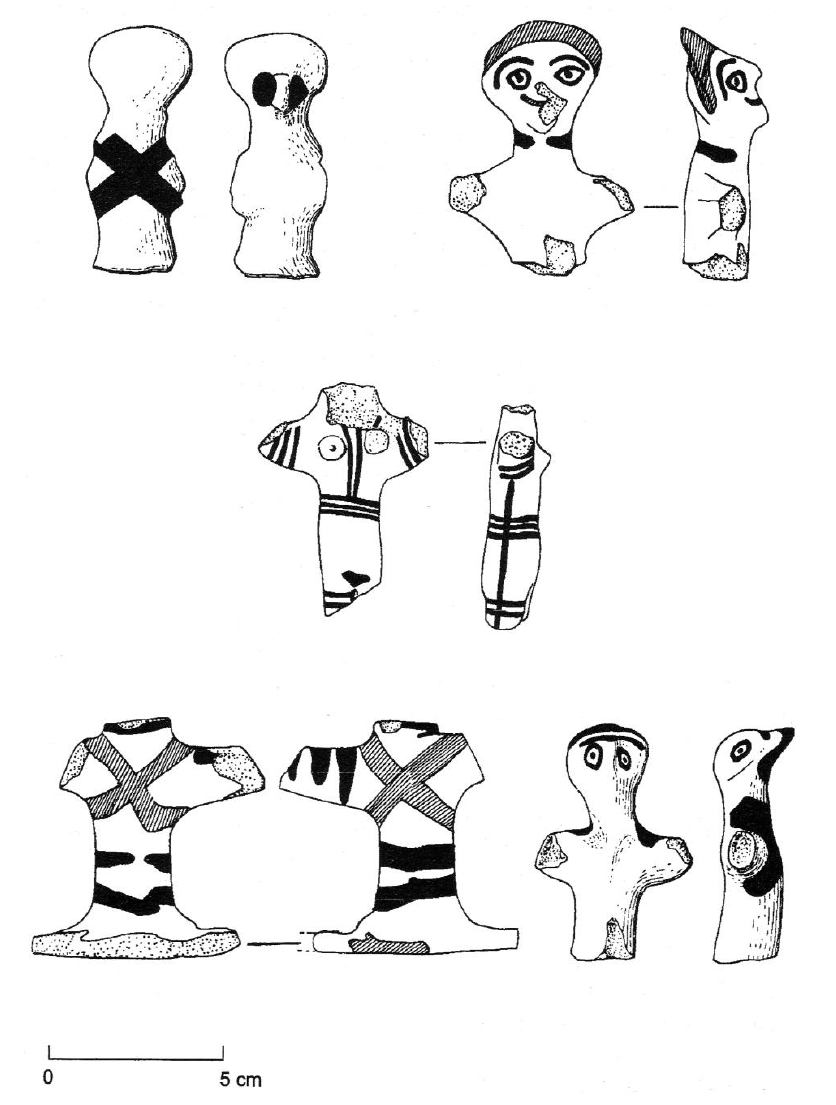
Figure 3. Terracotta figurines of the ‘goddess with upraised arms’ type from the sanctuary of the ‘Ingot God’ at Enkomi (after Webb 1999, p. 214, Figure